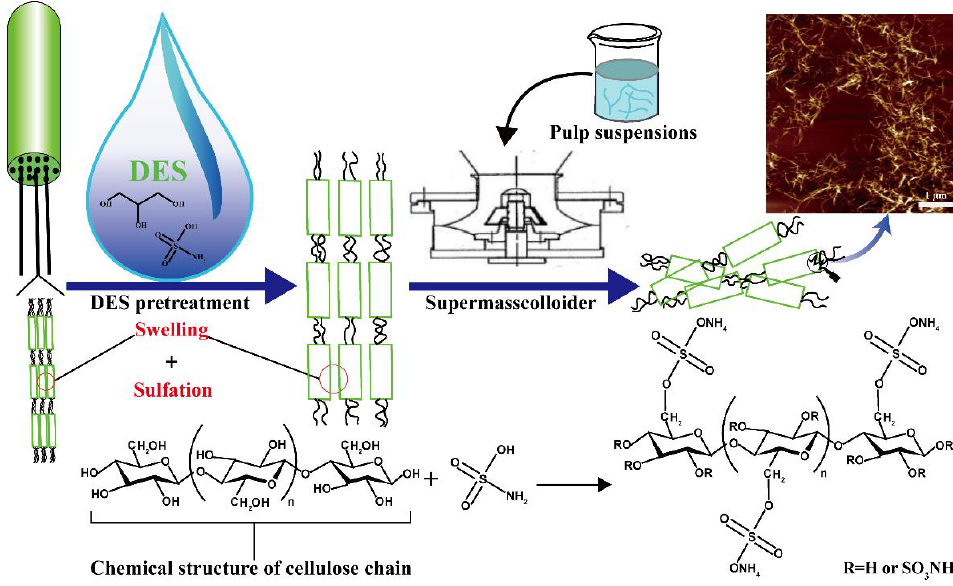
Figure 4. Schematic diagram for preparation of CNF through DES pretreatment.